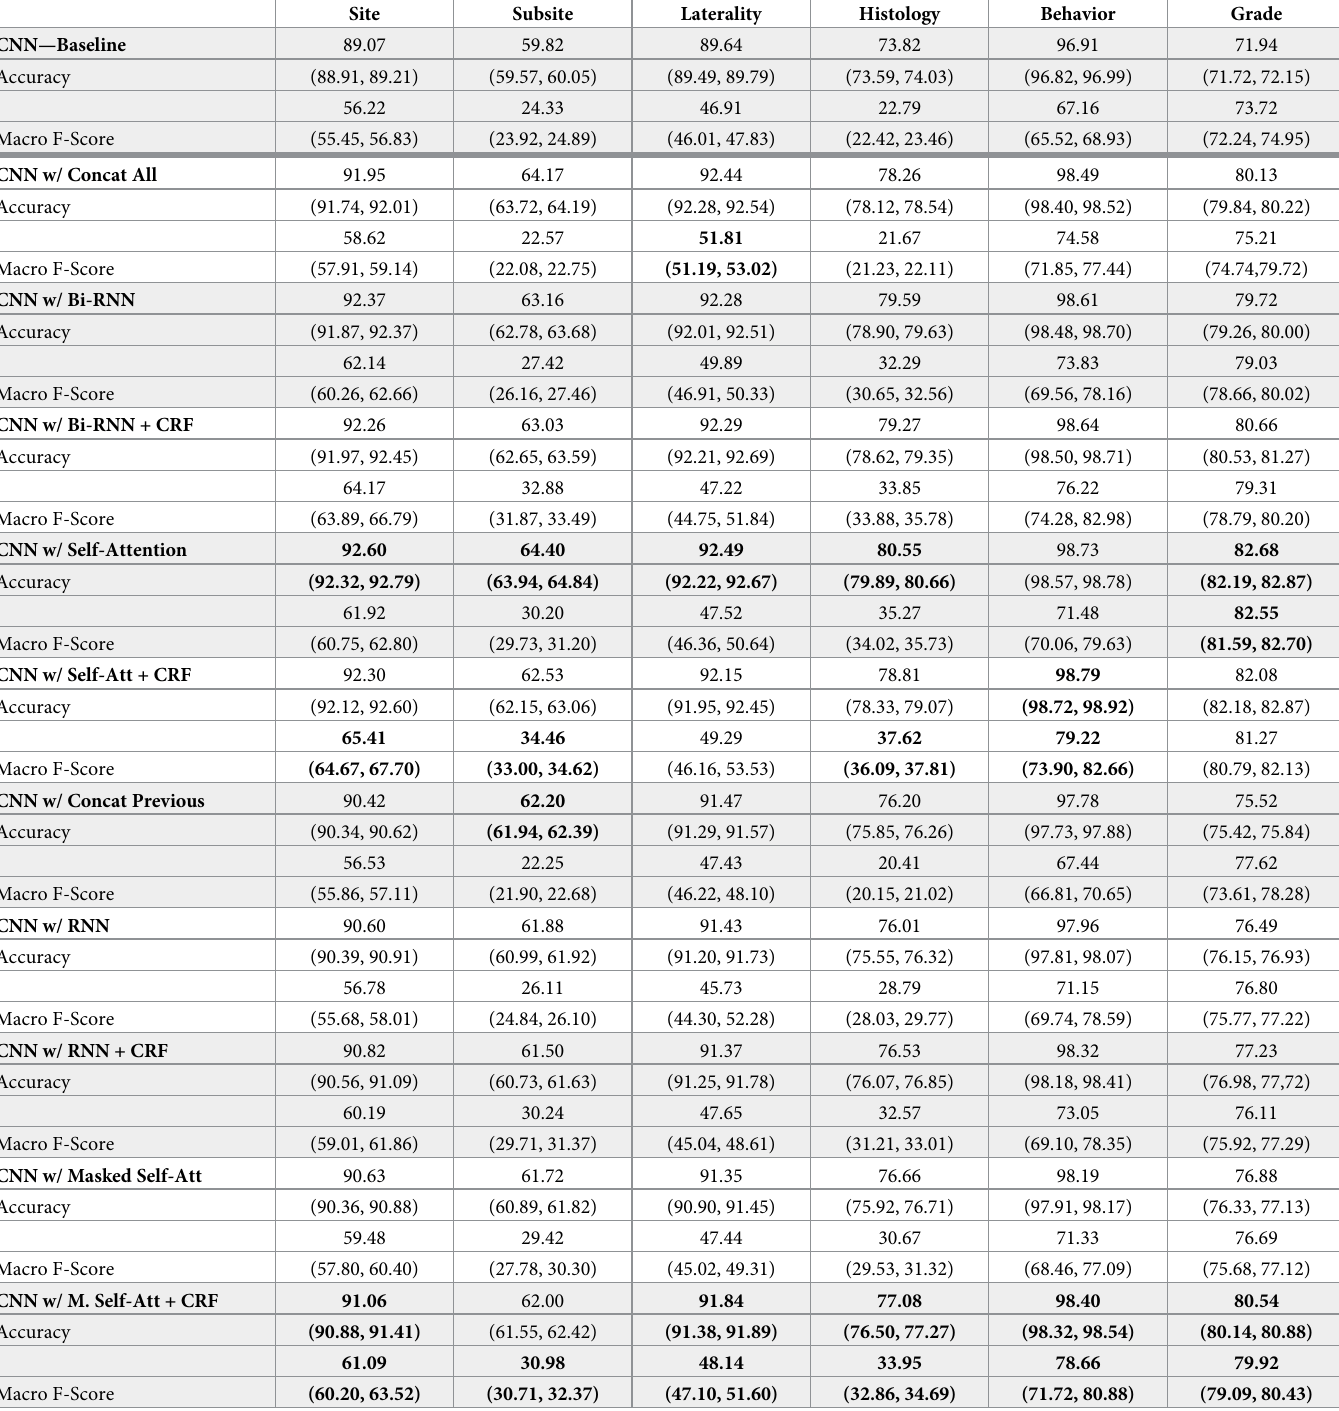
Table 1. Accuracy and macro F-Score (with 95% confidence intervals) of our different methods to capture case-level context on six different classification tasks using the CNN as the baseline. The top row is our baseline without any report level context, the middle group shows results of methods than can access both future and previous reports in a sequence, and the bottom group show results of methods that can only access previous reports in a